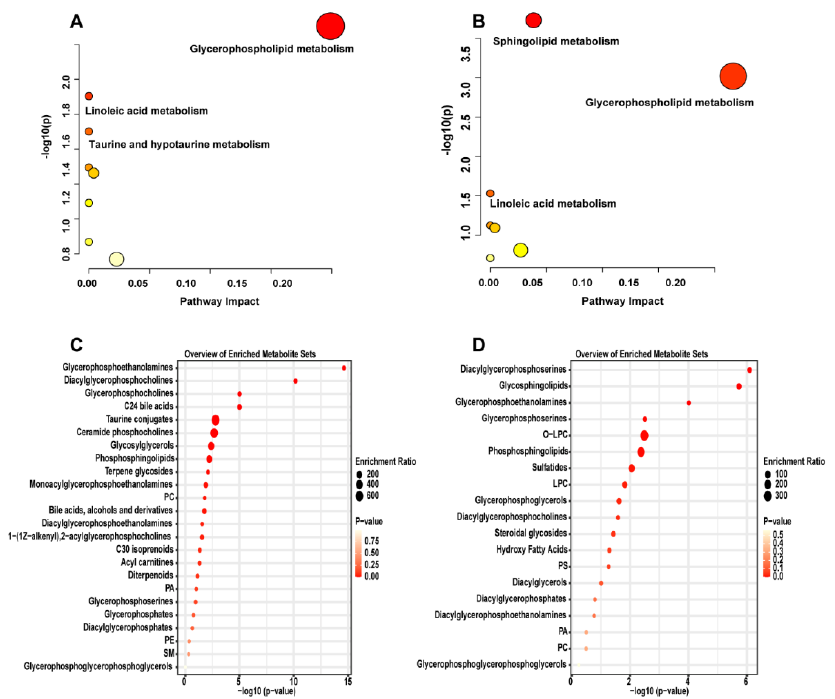
Figure 4. KEGG pathway analysis of differential metabolites in the small intestine ( A ) and large intestine ( B ) of the C57 and SR − B1 − / − mice. Metabolite enrichment analysis of the small intestine ( C ) and large intestine ( D ) in the C57 and SR − B1 − / − mice. 2.3. Scavenger Receptor Class B Type 1 Deficiency Influences the Amino Acid Contents in the Intestine Compared with those in the C57 mice, the levels of LYS, leucine (LEU), isoleucine (ILE), PHE, valine (VAL), MET, tryptophan (TRP), γ− aminobutyric acid (GABA), TYR, THR, and arginine (ARG) in the duodenum of the SR − B1 − / − mice were significantly in ‐ creased ( p < 0.001), while the levels of TAU, GLY, SER, glutamic acid (GLU), and aspartic acid (ASP) were significantly decreased (Figure 5, p < 0.05). Compared with those in the C57 mice, the levels of LEU, GABA, ILE, PHE, TYR, ARG, THR, and TRP in the jejunum of the SR − B1 − / − mice were obviously elevated ( p < 0.05), while the levels of ALA, TAU, SER, and ASP were significantly decreased ( p < 0.05). Compared with those in the C57 mice, the LYS, LEU, ILE, PHE, MET, TRP, TYR, THR, and ARG levels in the ileum of the SR − B1 − / − mice were obviously increased ( p < 0.01), while the levels of GABA, TAU, GLY, and SER were significantly decreased ( p < 0.05). The levels of LYS, ILE, LEU, PHE, GABA, TRP, TYR, MET, ALA, ASP, THR, SER, ARG, and GLY in the colon of the SR − B1 − / − mice were obviously lower than those in the colon of the C57 mice ( p < 0.05). Compared with those in the C57 mice, the levels of LYS, LEU, PHE, and TRP in the rectum of the SR − B1 − / − mice were obviously increased ( p < 0.01), whereas the levels of GABA, TYR, ALA, GLY, and SER were significantly reduced ( p < 0.05).